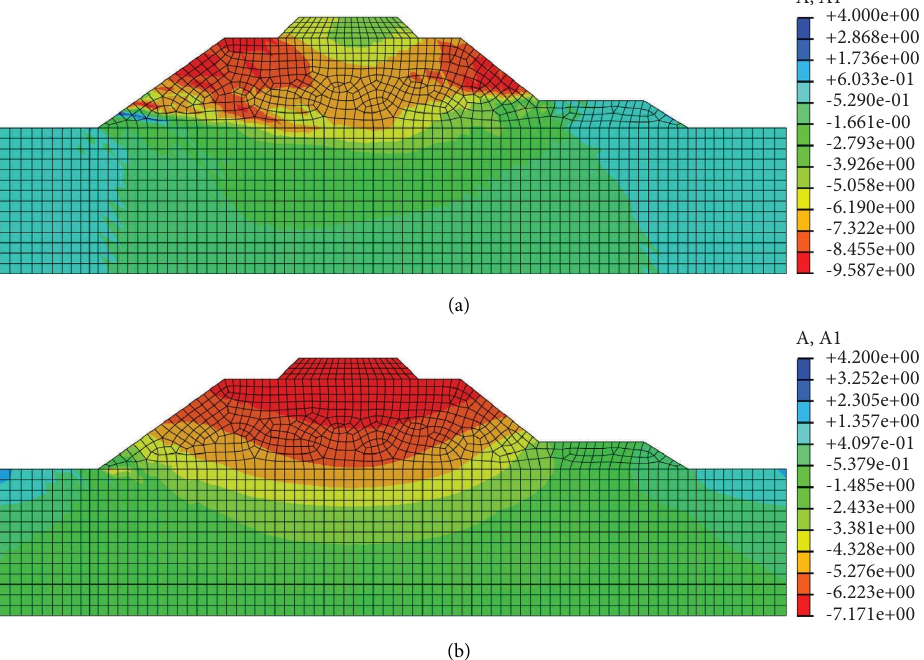
Figure 5: Te Peak ground horizontal acceleration contour in diferent seasons: (a) horizontal acceleration contour map of the embankment in the warm season; (b) horizontal acceleration contour map of the embankment in the cold season.